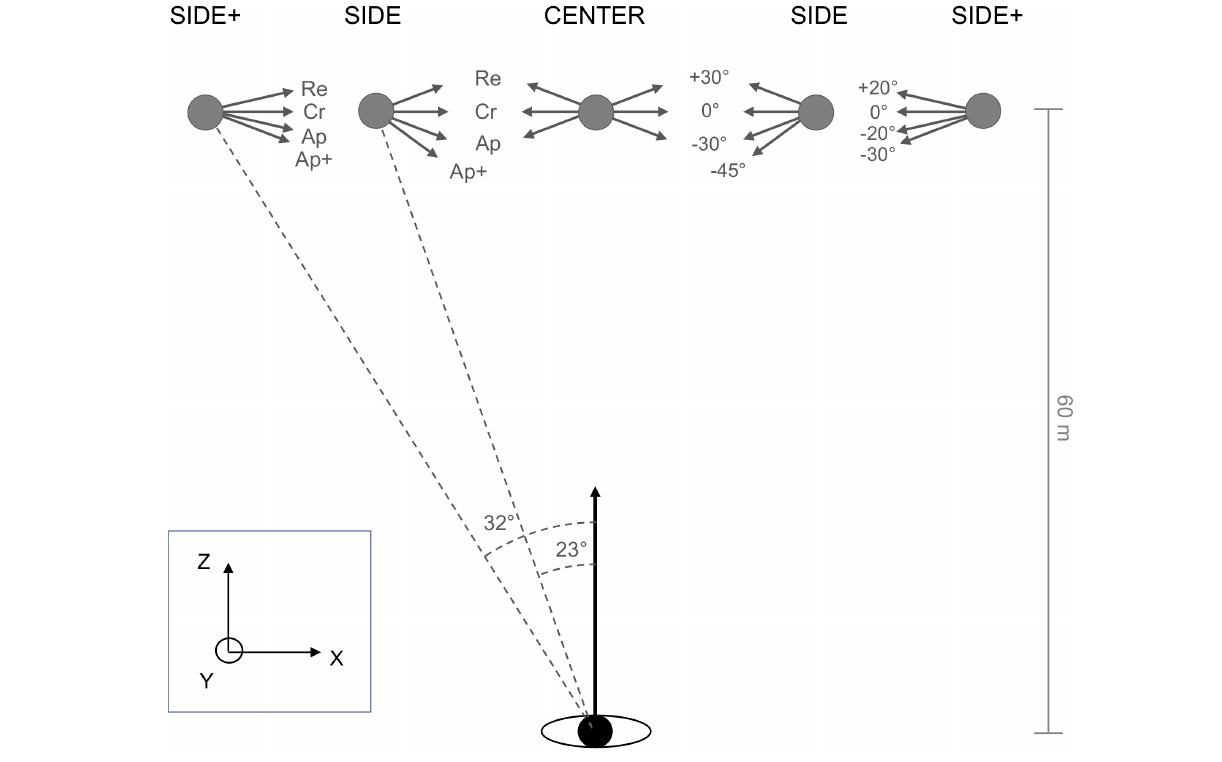
FIGURE 2 | Plan view of the initial conditions of the experiment. The moving target appeared at CENTER (0 ◦ ), SIDE (23 ◦ ), or SIDE+ (32 ◦ ) eccentricities with respect to the participant’s initial heading direction. Under CENTER and SIDE eccentricity conditions, the target moved at 10 m/s along Cross (Cr, 0 ◦ ), Retreat (Re, +30 ◦ ), and Approach (Ap, –30 ◦ ) directions, with an additional Approach+ (Ap+, –45 ◦ ) direction added under the SIDE eccentricity condition. Under the SIDE+ eccentricity condition, the target moved at 15 m/s along Cross (Cr, 0 ◦ ), Retreat (Re, +20 ◦ ), Approach (Ap, –20 ◦ ), or Approach+ (Ap+, –30 ◦ ) directions.